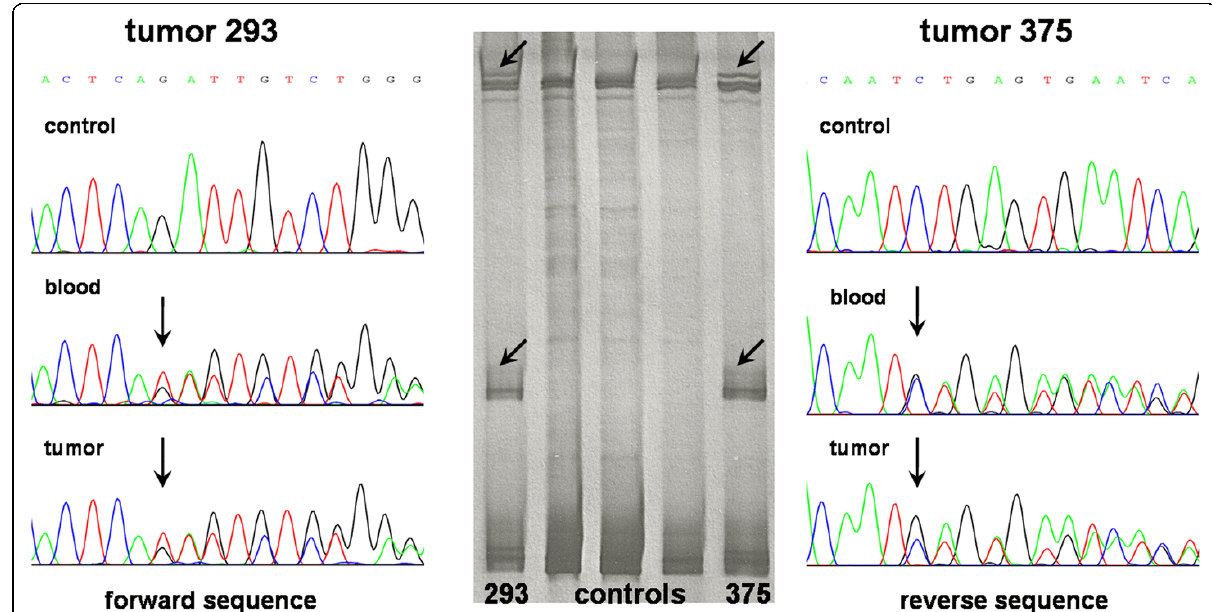
Figure 1 The c.509_510delGA detected in the PALB2 gene in ovarian carcinomas . SSCP gel (in the middle) - shifted bands are indicated by arrows; on sequencing diagrams the deletion site is indicated by